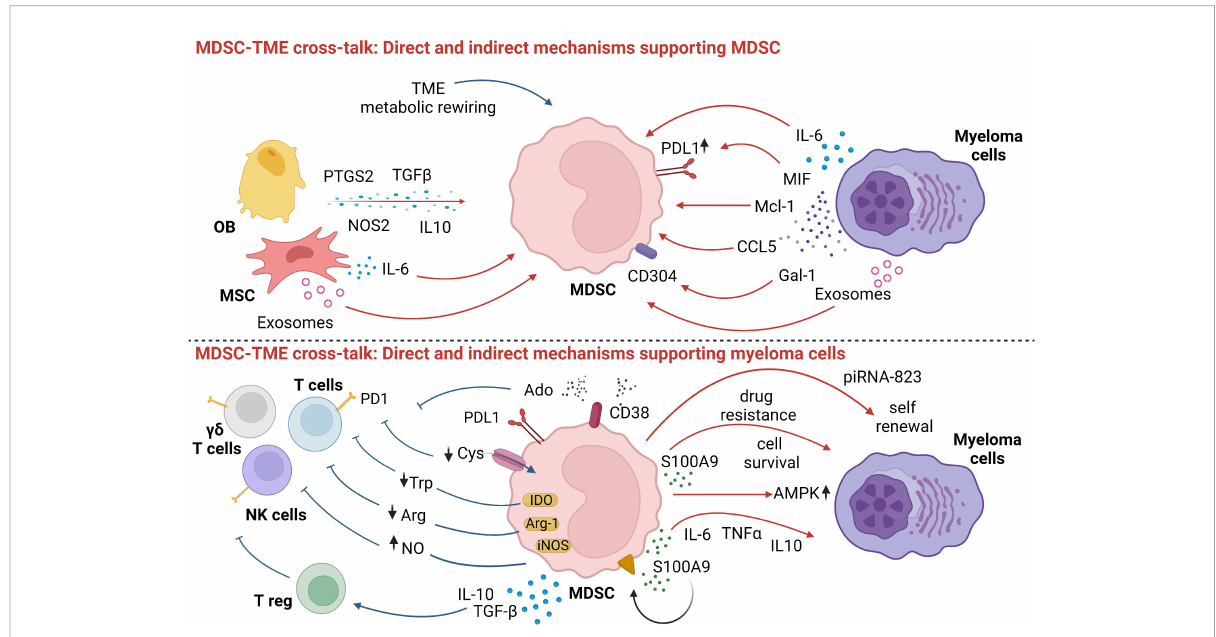
FIGURE 1 Myeloma cell and surrounding cells promote MDSC differentiation and suppressive functions. In turn, MDSC undermine anti-tumor immune responses and guarantee myeloma cells survival and growth. Red arrows: direct mechanisms; blue arrows: indirect mechanisms. Created by